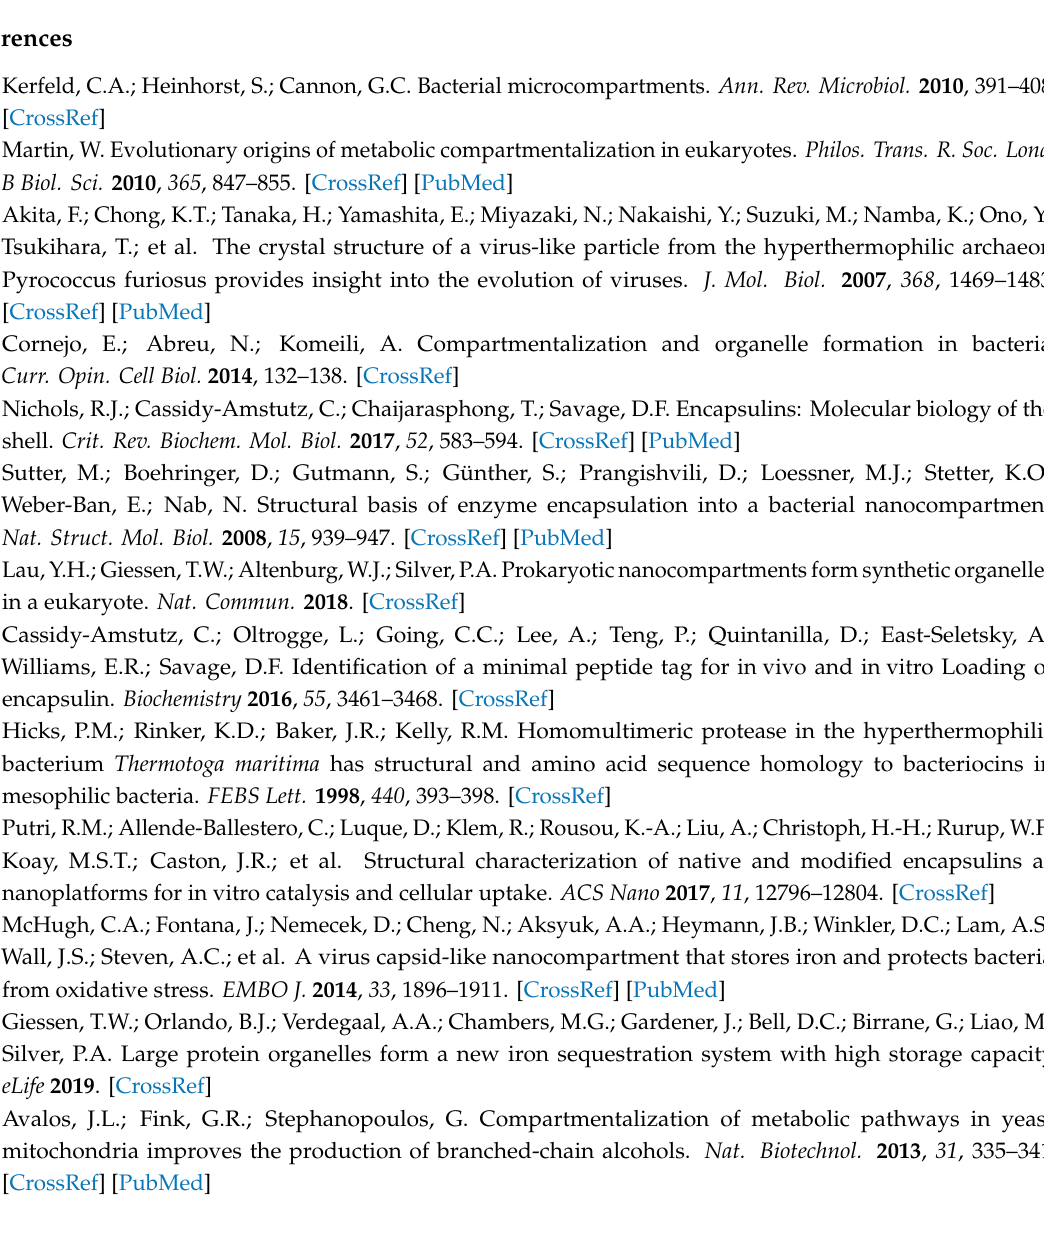
Figure S1: The Rosetta refined monomer model superimposed with the density map, Figure S2: The extra density of the inner capsid in the focused refinement of the threefold pore, Figure S3: The FSC curve of C1 symmetry reconstructed map reported by